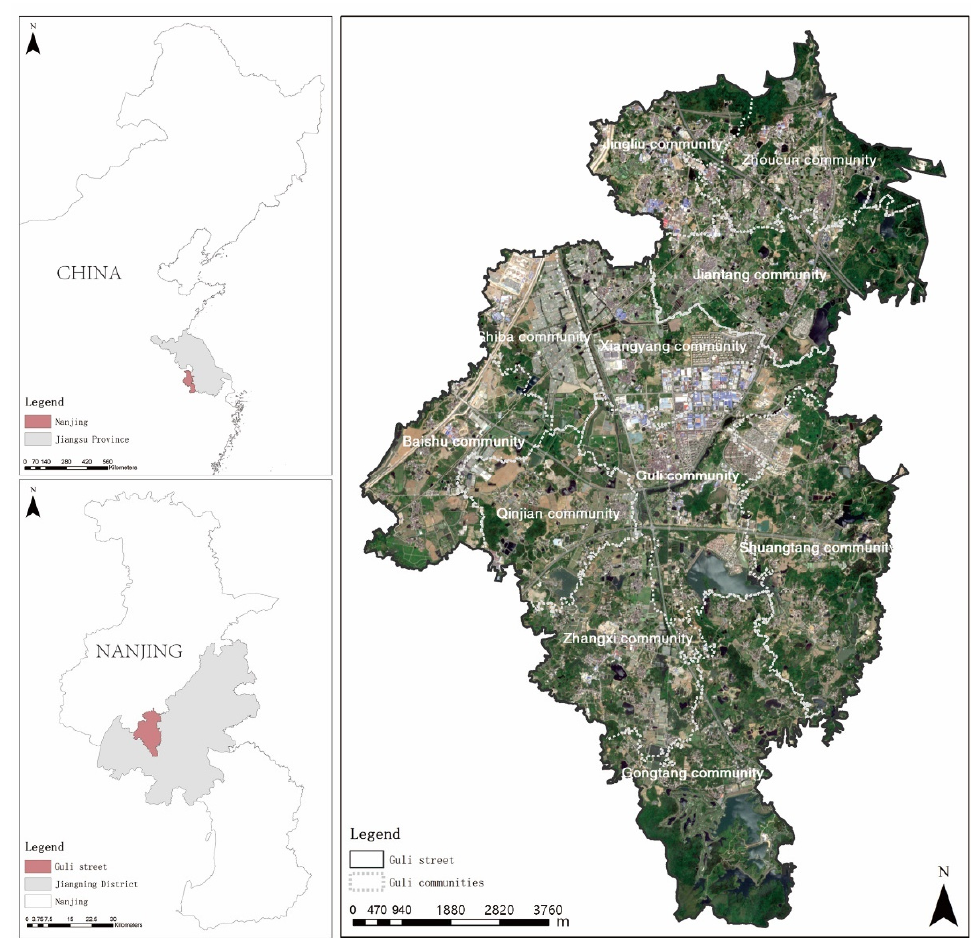
Figure 1. The geographical location and administrative division of Guli Street.